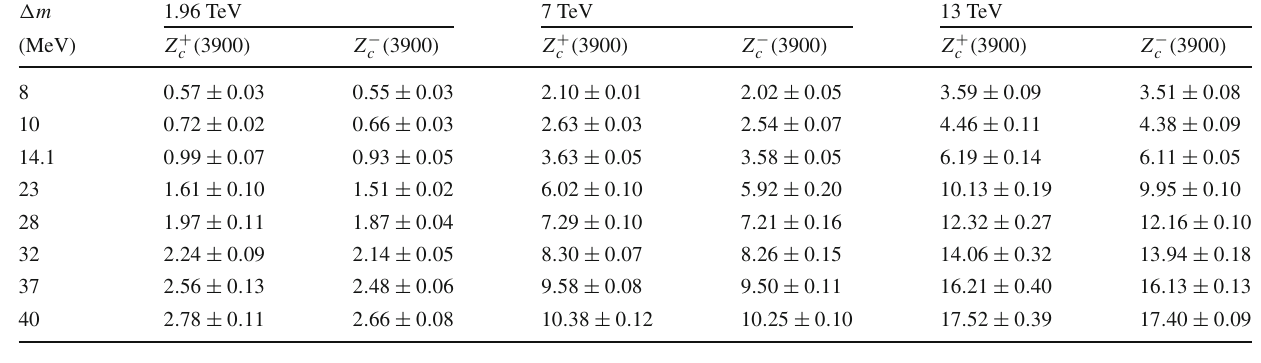
Fig. 1 The distribution of the yield of exotic resonant states Z ± c ( 3900 ) in pp collisions at √ s = 1 . 96 , 7 , 13 TeV, respectively. a As a function of mass uncertainty (cid:5) m , b as a function of radius parameter R 0 . The data are calculated using PACIAE+DCPC model based on the Z ± c ( 3900 ) → J /ψπ ± bound state in the decay chain of b